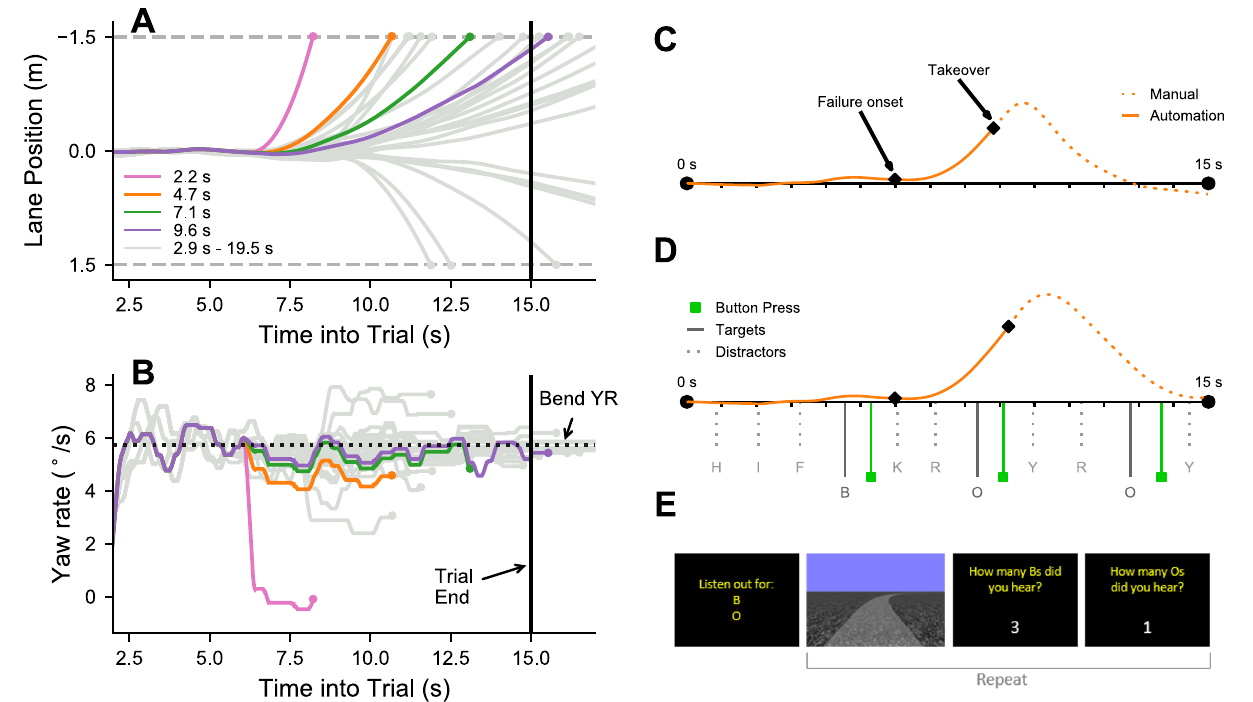
Fig 1. Simulated failures. (A) The trajectories of the simulated failures across the entire trial, including the different replayed trajectories (automation), and varied failure onset times. In the figure the road has been straightened out, with the horizontal dashed grey lines indicate the road edges and negative Lane Position values correspond to understeering. (B) The yaw-rate profiles of the simulated failures. Note that the coloured trajectories, which are the Repeated failures (6 repetitions of 4 variations, with an identical replayed trajectory and onset time), all follow the same yaw-rate profile until 6 s, whereupon there is a constant offset to yaw-rate. Solid grey trajectories are the Non-Repeated failures (24 variations), which varied in both replayed trajectories and onset times. Dots correspond to when the trajectory leaves the road. The failure parameter TLC F is shown in the legend. TLC F represents the amount of time elapsed between when the failure is introduced and when the driver, represented by a single point, would hit the lane boundaries in the absence of a steering response. Panels C-E show The Trial Sequence. The locomotor component of each trial was 15 s. A bias was introduced in every trial, but severity ranged from negligible to requiring rapid action (Fig 1). (C) A sample SupAuto trial (Repeated; TLC F = 4.7 s; Onset time = 6 s) with the lane position signal overlaid. (D) A sample SupAuto+ACMT trial (Repeated; TLC F = 4.7 s; Onset time = 6 s) showing the ACMT presentation timings and the participant’s button responses. (C) The trial sequence for SupAuto+ACMT. Two target letters were presented at the start of each block of trials. Each trial consisted of the supervising automation task (visual scene shown), followed by the participant estimating how many of each target they had heard. For SupAuto blocks (without the cognitive task), there was a brief blackout at the end of each trial, then the visual scene was reset. For more information see Materials and